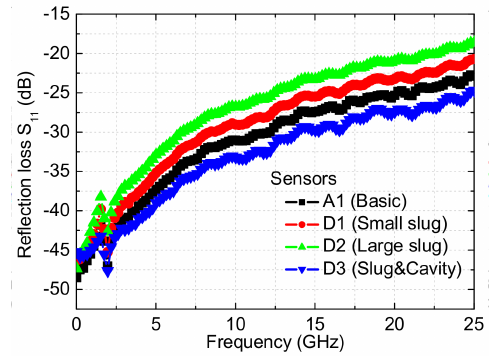
Figure 7. Measured reflection losses of the basic and improved thermopile-based microwave power